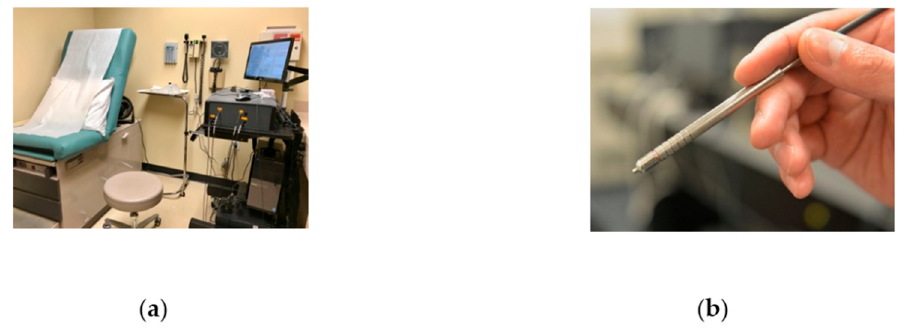
Figure 2. ( a ) Optical instrument system for clinical data acquisition in the clinic examination room. ( b ) The handheld fiber probe enables acquisition of Raman spectral data.